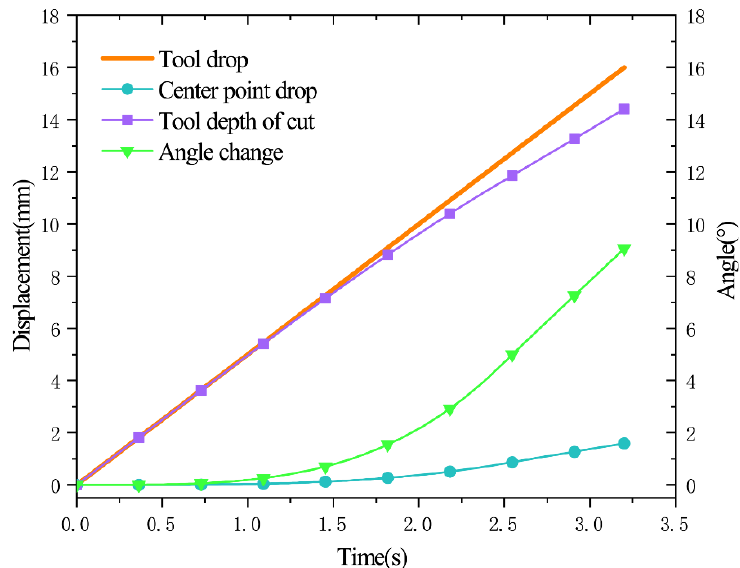
Figure 12. Compress the trajectory of each point.